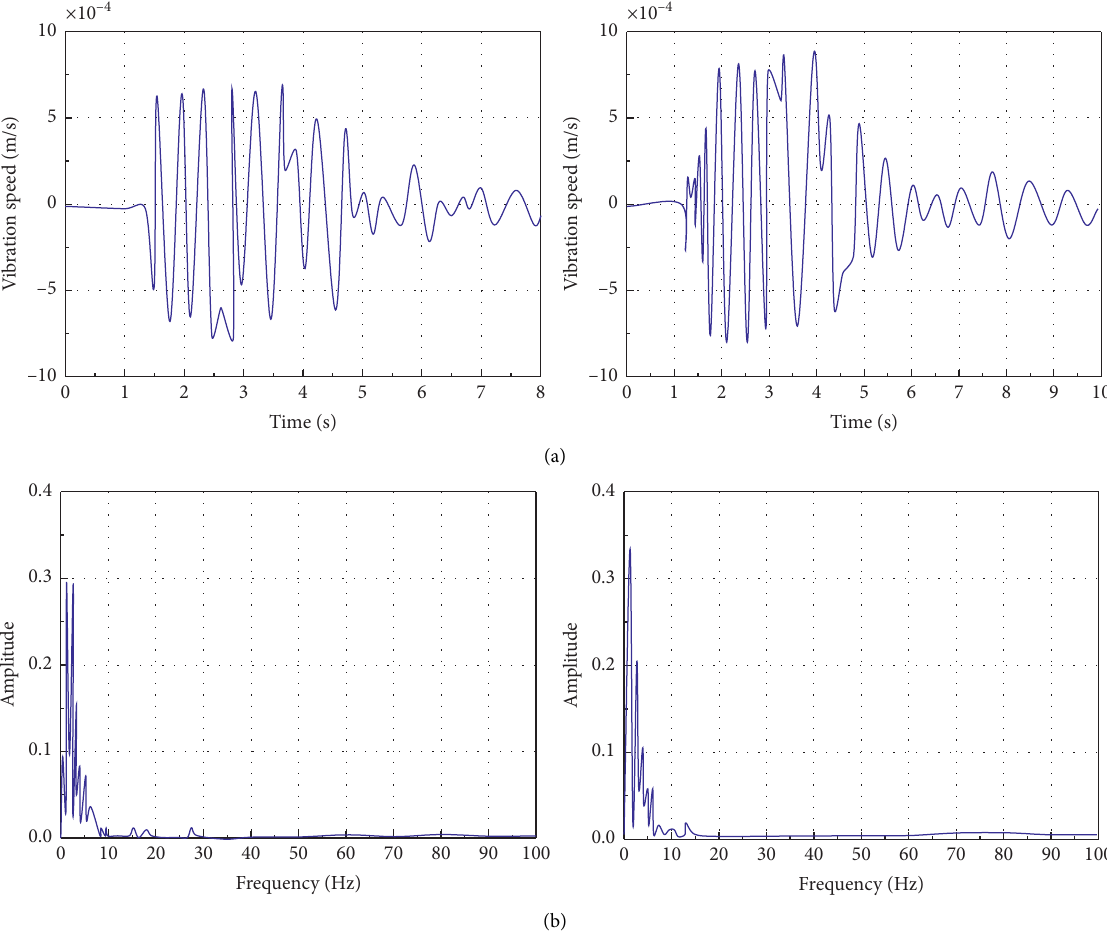
Figure 1: Spectrum characteristic of partial channel vibration waveform: (a) velocity-time history waveform of partial channel and (b) partial channel